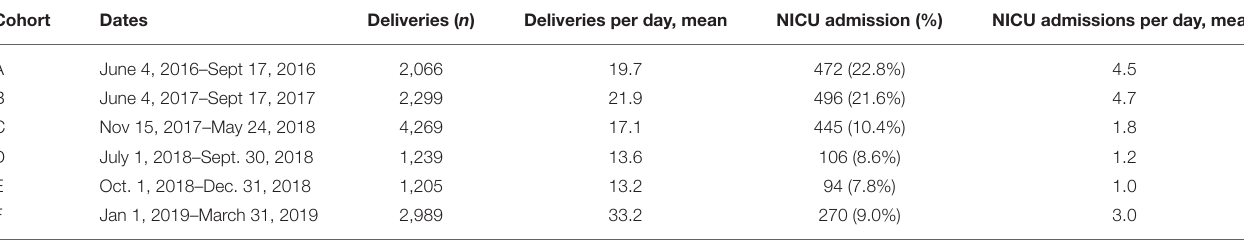
TABLE 2 | Birth rate and NICU admission rate before and during the initial two periods after implementation of the NALS service. Cohort Dates